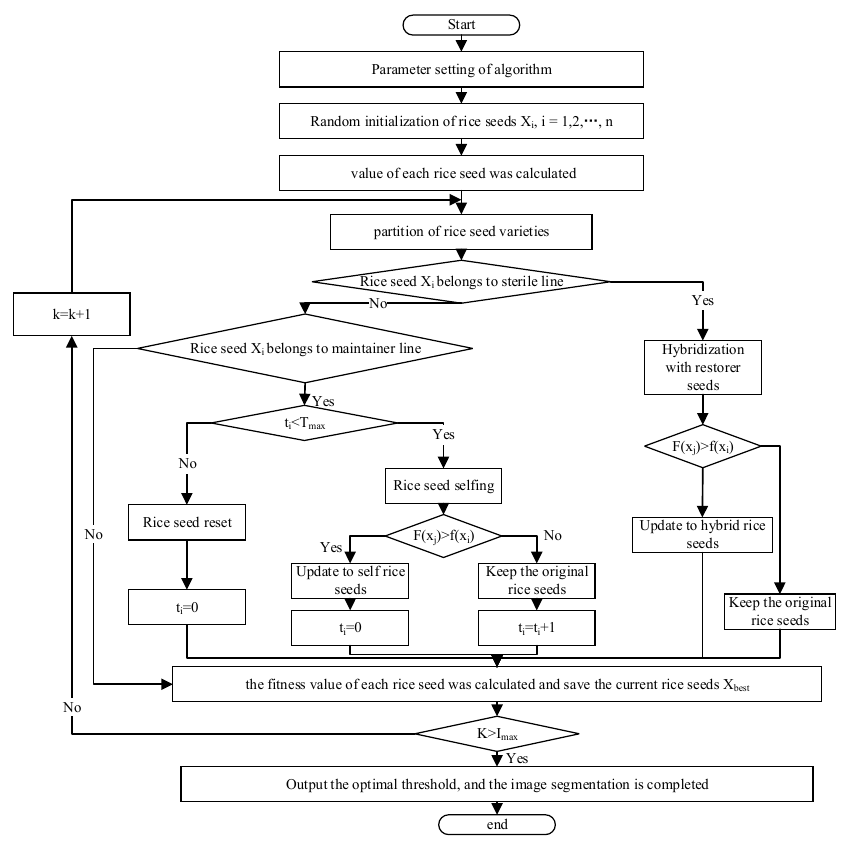
Figure 2. The procedure of the proposed scheme.